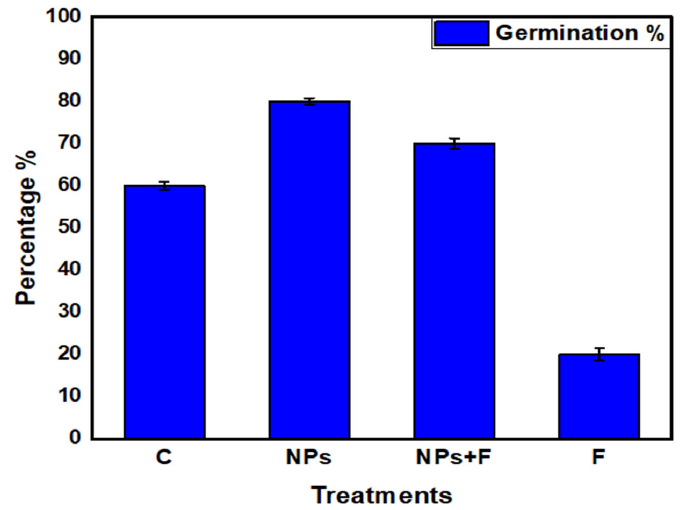
Figure 11. Germination percentage of chickpea seeds under different growth